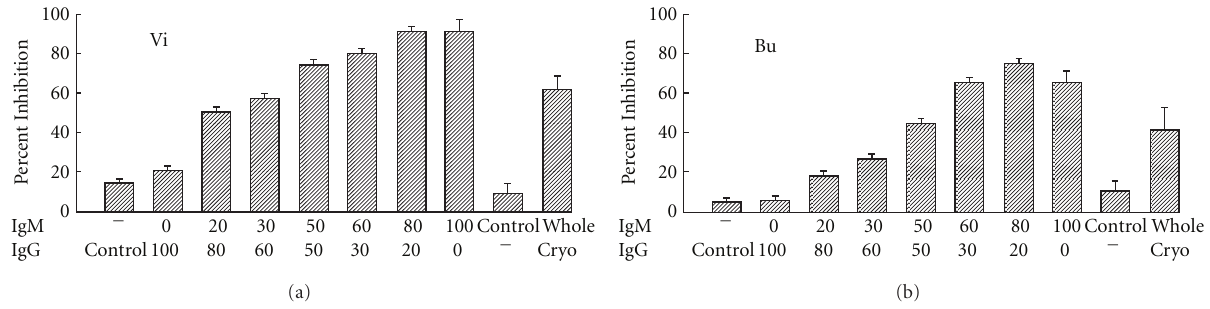
Figure 2: Total hemolytic complement activity was determined after reconstitution of varied molar ratios of separated IgM and IgG from two type 2 cryoglobulins (Vi; Bu). Separated IgM was 100% monoclonal IgMk with RF activity; the IgG fraction had immunoblot reactivity to multiple HCV linear antigens. Isolated cryoglobulin was significantly (40 and 60% total serum RNA by RT-PCR) enriched in HCV RNA. Separated IgM and IgG fractions were mixed at 37 and cooled O/N to 4 C. Results are compared to control IgG and IgM, the latter from a patient with Waldenstr¨oms macroglobulinemia without RF activity. Both cryoglobulins were obtained from patients chronically infected with HCV, with active cutaneous vasculitis and membranoproliferative glomerulonephritis. (courtesy of Dr. B.